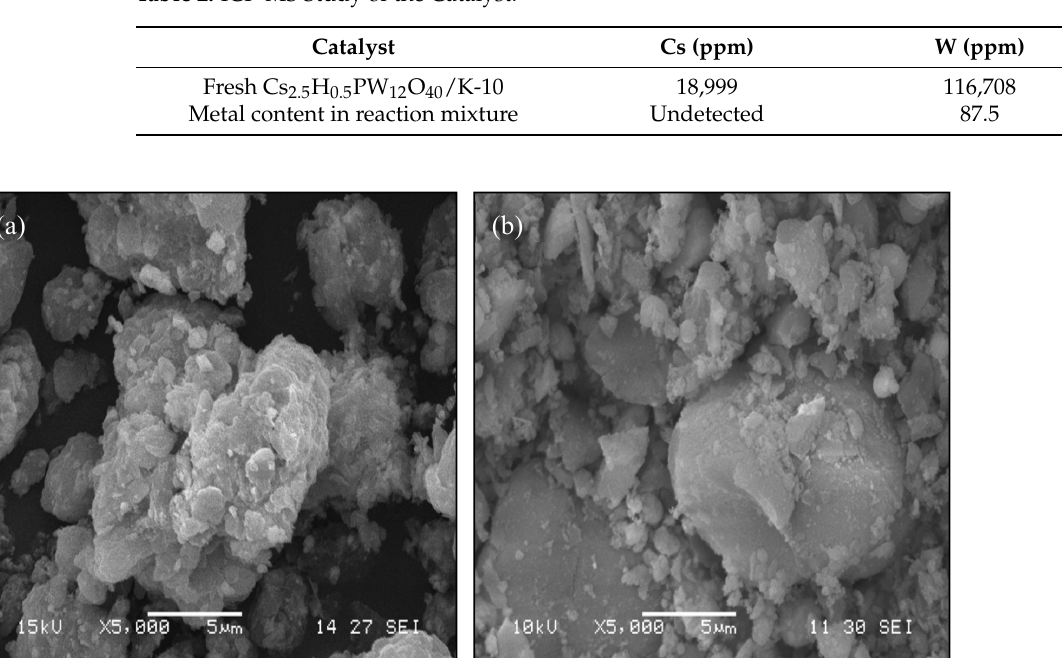
Table 2. ICP-MS Study of the Catalyst.